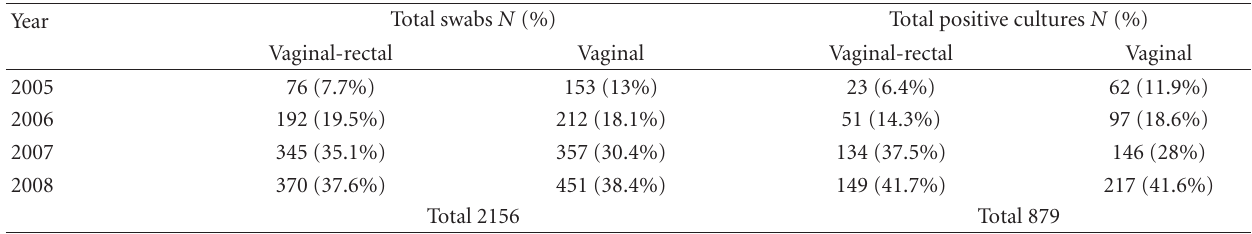
Table 2: Distribution (number and percentage) of resistant GBS strains during the 4-year study period.